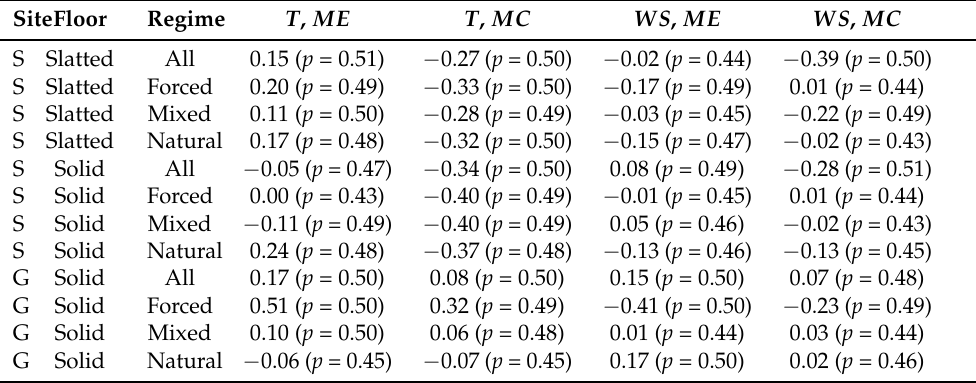
Table 5. Kendall’s rank correlation between air temperature ( T ), wind speed ( WS ), CH 4 emission ( ME ) and CH 4 concentration ( MC ). For each site (i.e., S = Switzerland, G = Germany) and flooring system, the correlation was calculated based on all data, as well as based on subsets associated with the regimes forced, mixed and natural convection. p -values in brackets indicate the exceedance probability of normally distributed random variable sets (see Section